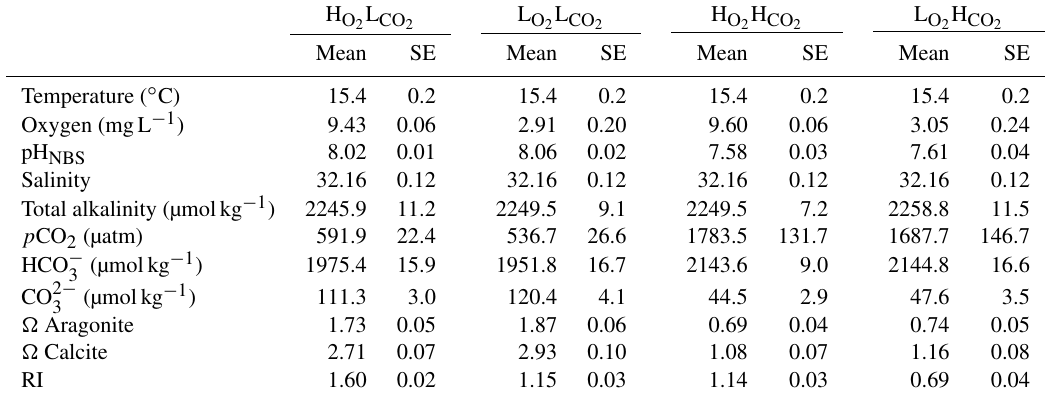
Table 2. Realized carbonate chemistry and oxygen concentrations for the four treatments (H O Values are averages ± SE of measurements and calculations (using CO2SYS). Respiration Index (RI) as defined by Brewer and Peltzer (2009) (see Sect. 2.4 for